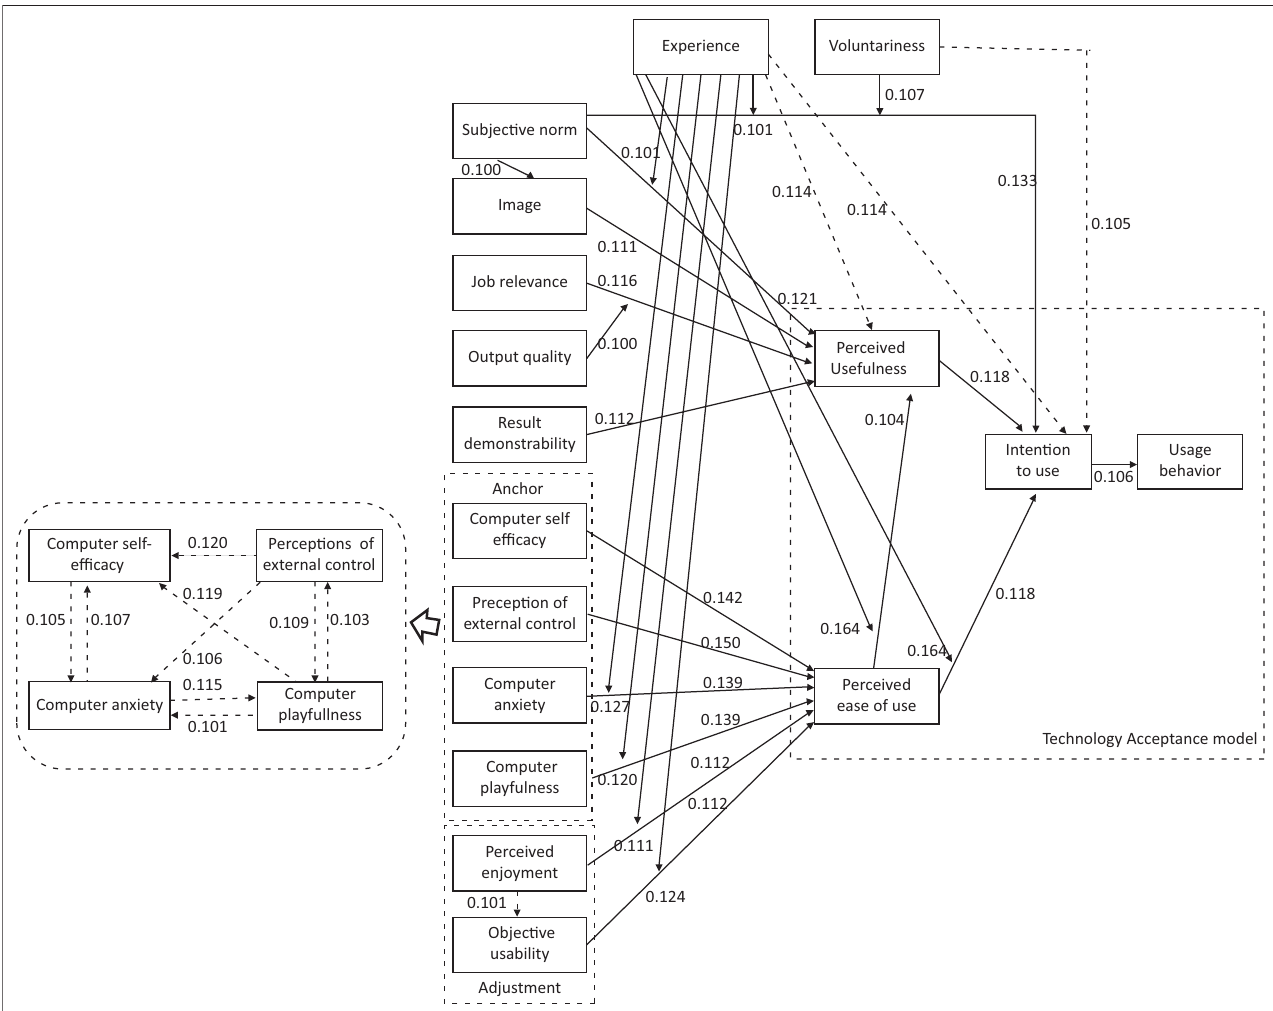
FIGURE 6: Influence